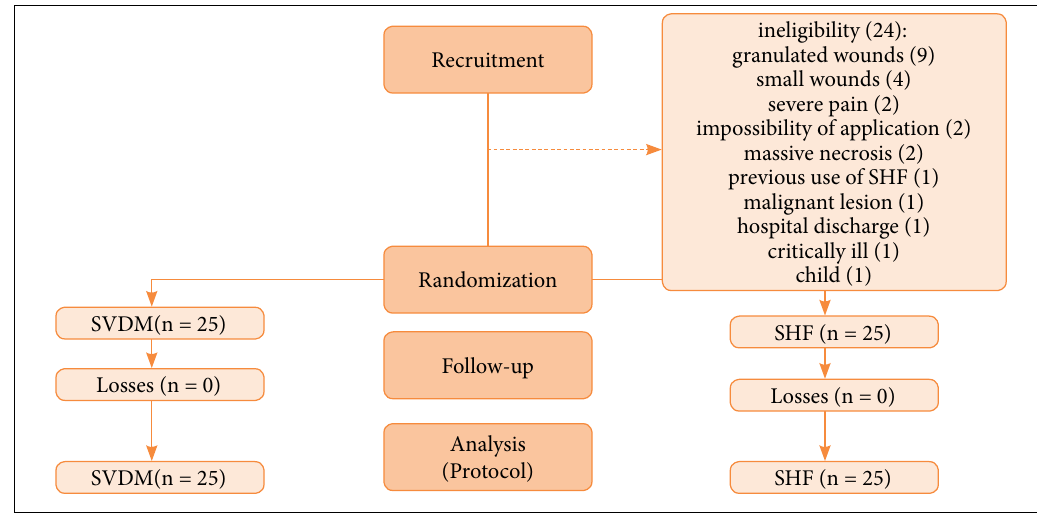
Figure 4 - Flow diagram. Table 1 - Demographic characterization of samples according to